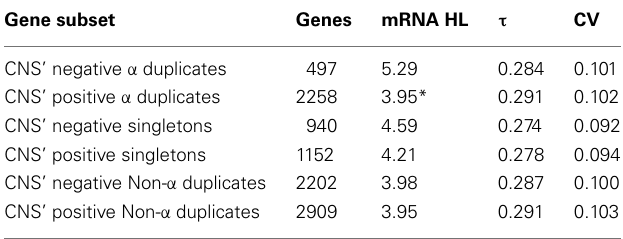
Table 2 | Gene expression characteristics based on CNS’